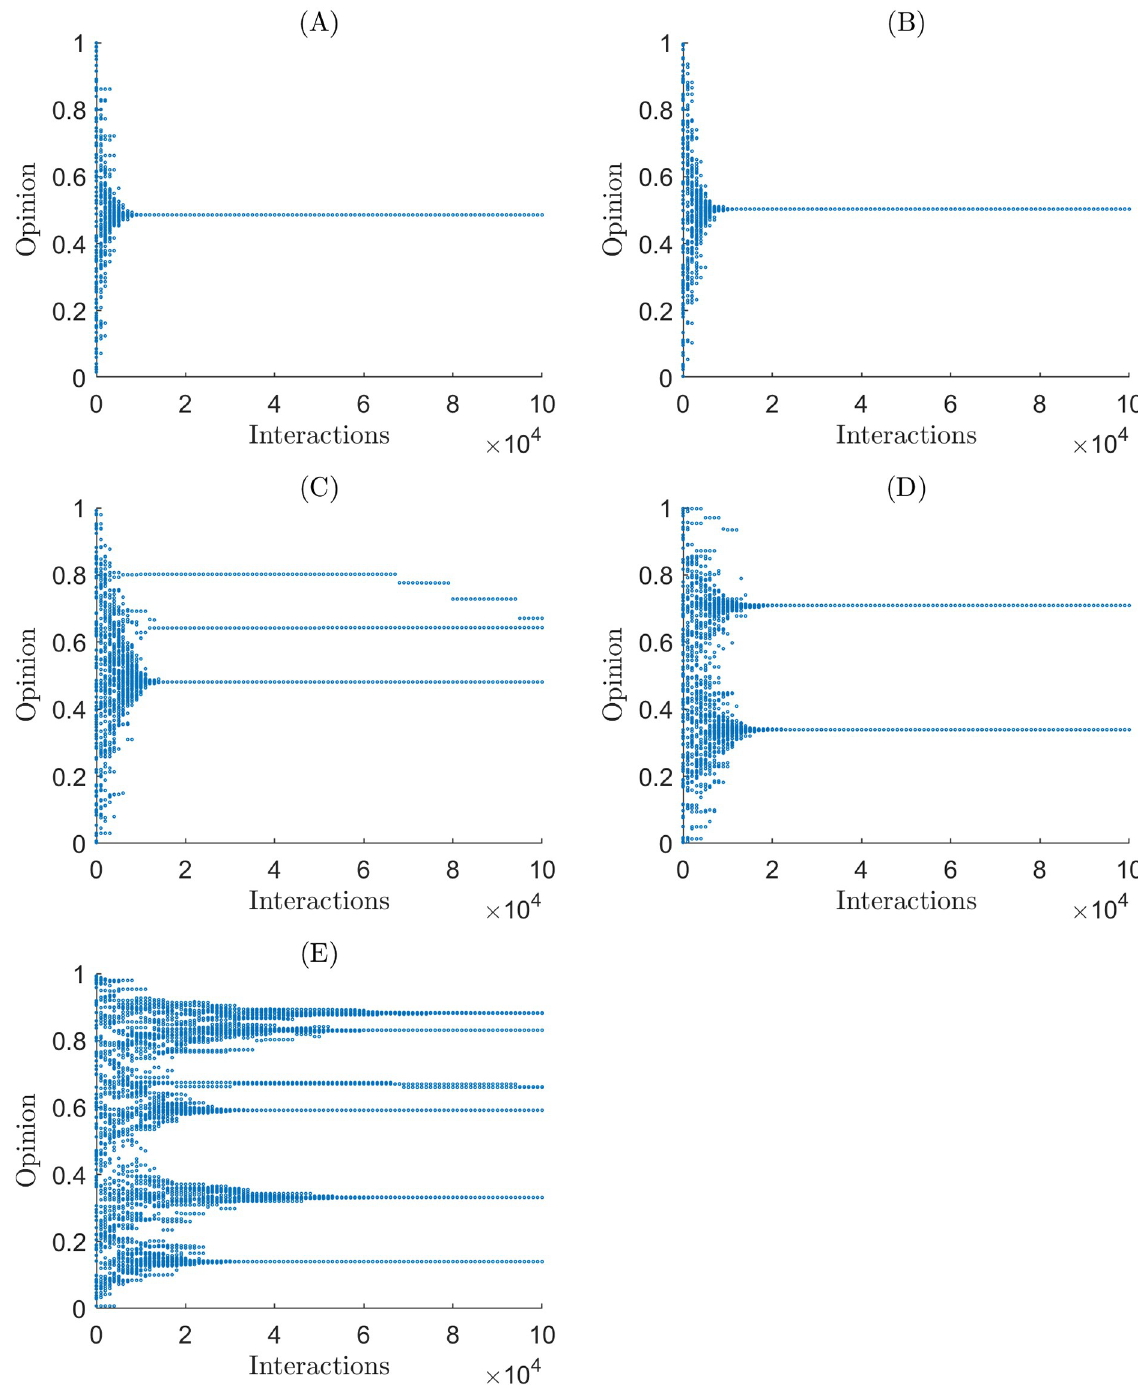
Fig 2. Sample simulations’ opinion shifts of agents through time for the extended Martins model under different initial uncertainty. (A) A simulation with an initial σ = 0.5. (B) A simulation with an initial σ = 0.2. (C) A simulation with an initial σ = 0.14. (D) A simulation with an initial σ = 0.1. (E) A simulation with an initial σ =